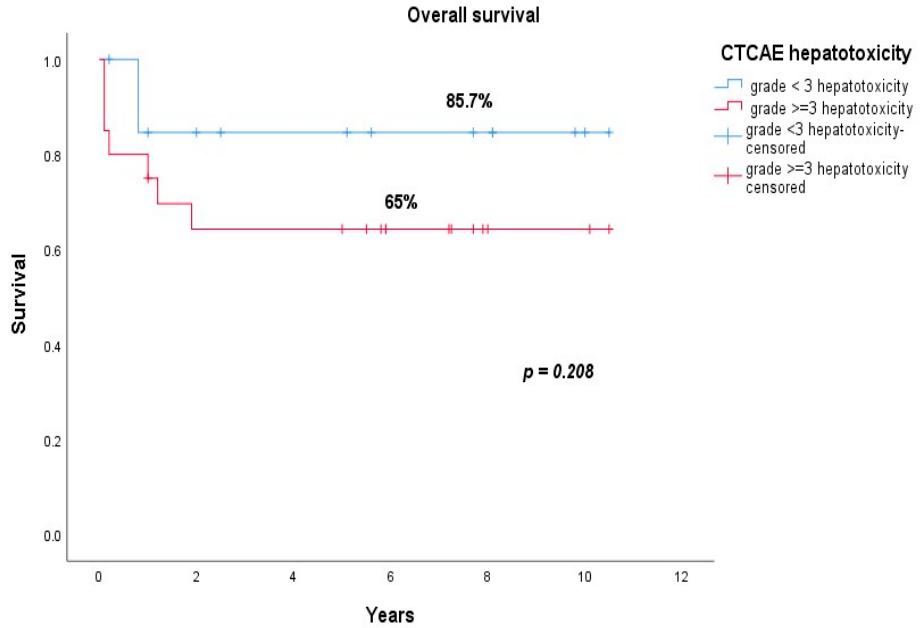
Figure 4. EFS of patients with CTCAE grade < 3 hepatotoxicity (blue line) vs. grade ≥ 3 hepatotoxicity (red line).